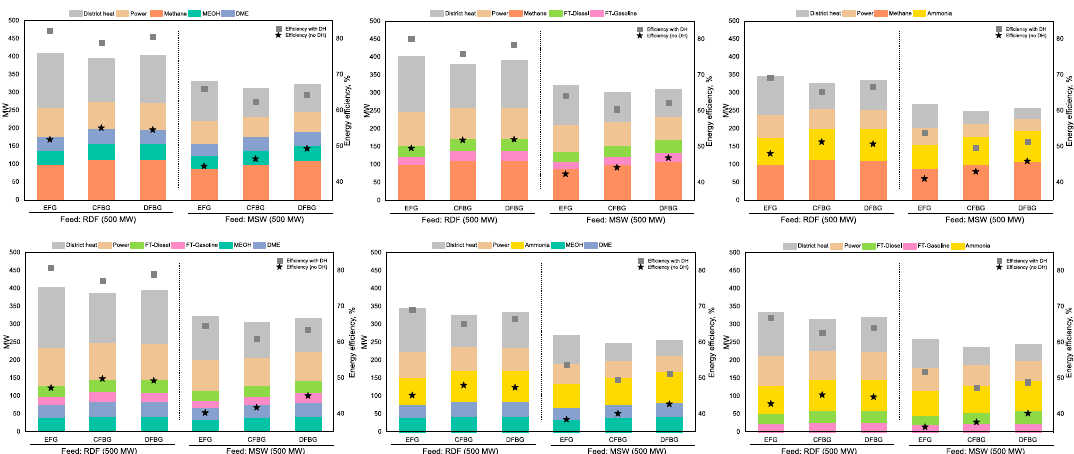
Figure 16. Polygeneration of power, heat and two biofuels from RDF and MSW gasification in the three gasifiers (EFG, CFBG and DFBG). Total feed = 500 MW; an equal amount of syngas was transferred for the production of power and the two biofuels in each case.